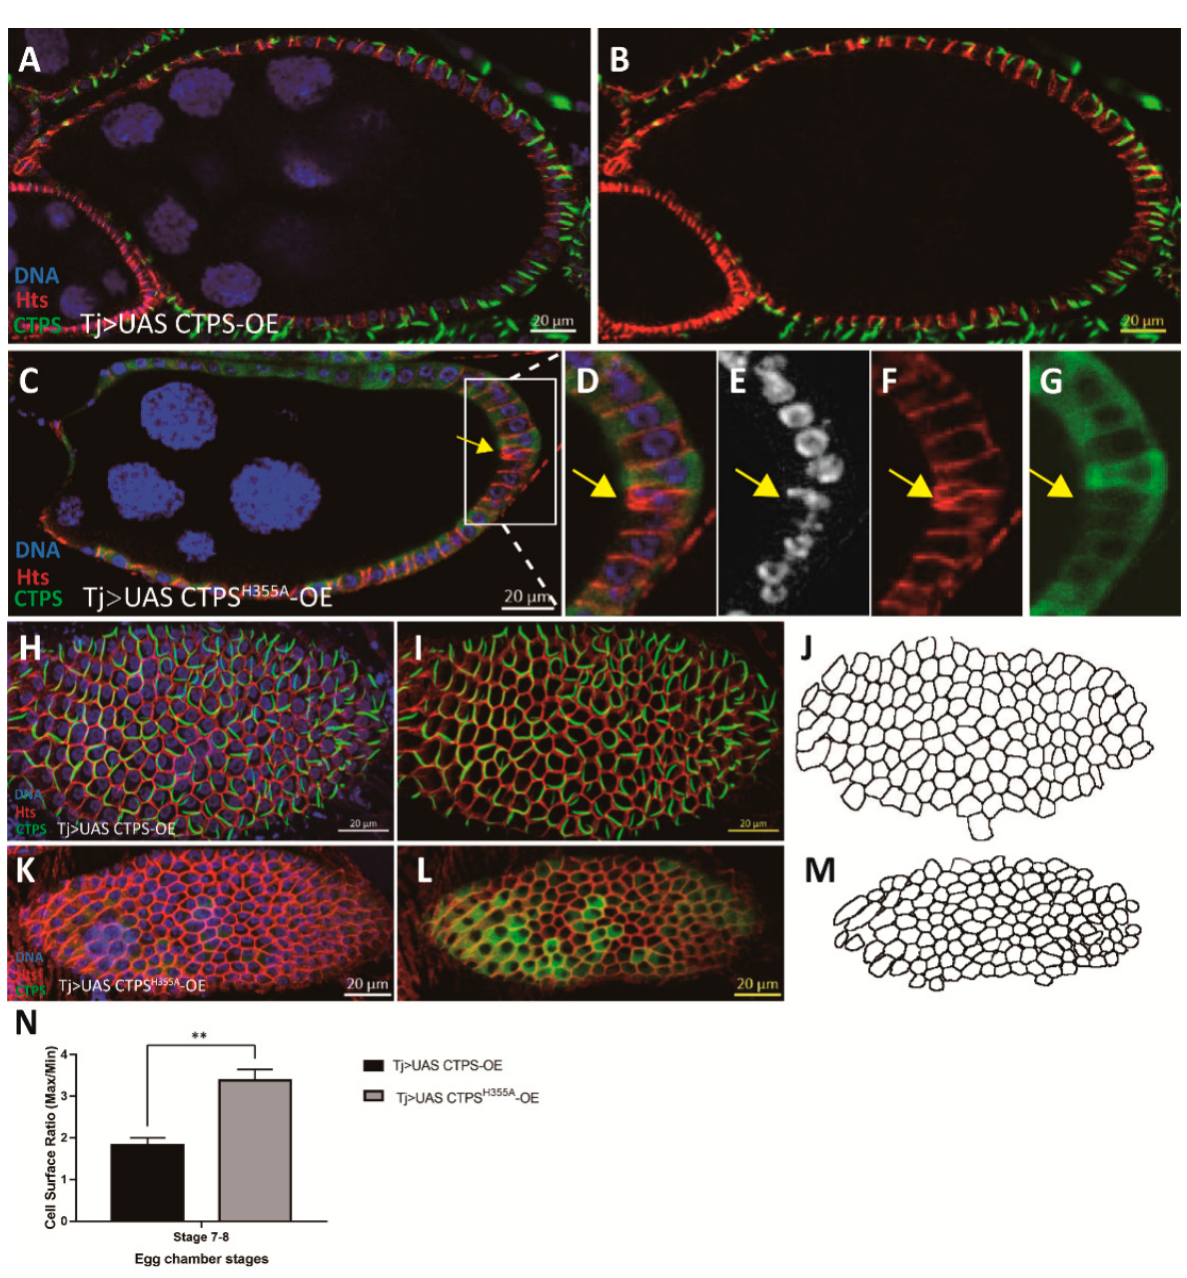
Figure 11. Follicle cell ingression occurs with follicle cell-specific overexpresson of CTPS H355A . ( A , B ) Side view of a stage 8 egg chamber overexpressing CTPS in follicle epithelium. ( C ) Cross section of stage 8 egg chamber after overexpression of CTPS H355A in follicle epithelium. The ingression is framed by a rectangle. ( D–G ) Zoom-in of the ingressive follicle cell in ( C ). ( H–J ) Surface view of a stage 8 egg chamber with follicle cell-specific overexpression of CTPS. Large cytoophidia are detectable in almost all follicle cells. Note that most cytoophidia are distributed on or near the cortex of follicle cells. ( K–M ) Surface view of a stage 8 egg chamber with follicle cell-specific overexpression of CTPS H355A . No cytoophidium is detectable. CTPS-mCherry (green), Hts (red) and DNA (blue, labelled with Hoechst 33342). Scale bars, 20 µ m. ( N ) Quantitative analysis of the ratio of three largest cells versus three smallest cells (5 images/genotypes, 3 biological replicates). Mann-Whitney U test, **, p = 0.002.